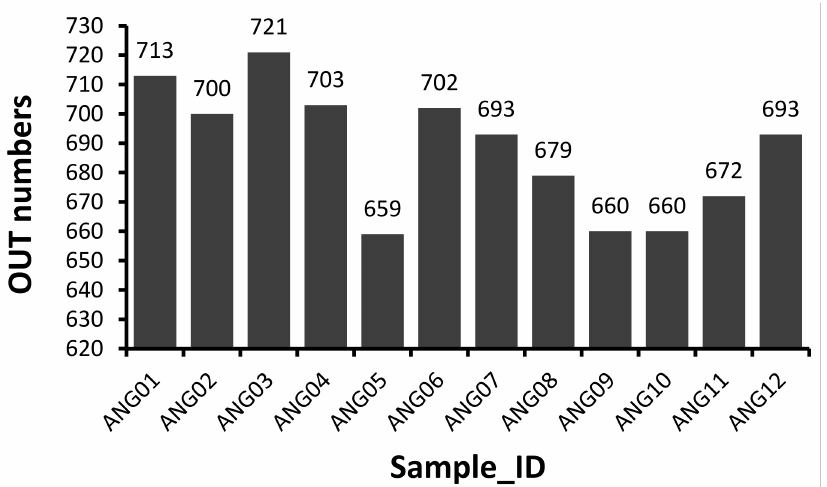
Figure 1. Distribution of 16S OTU number of each